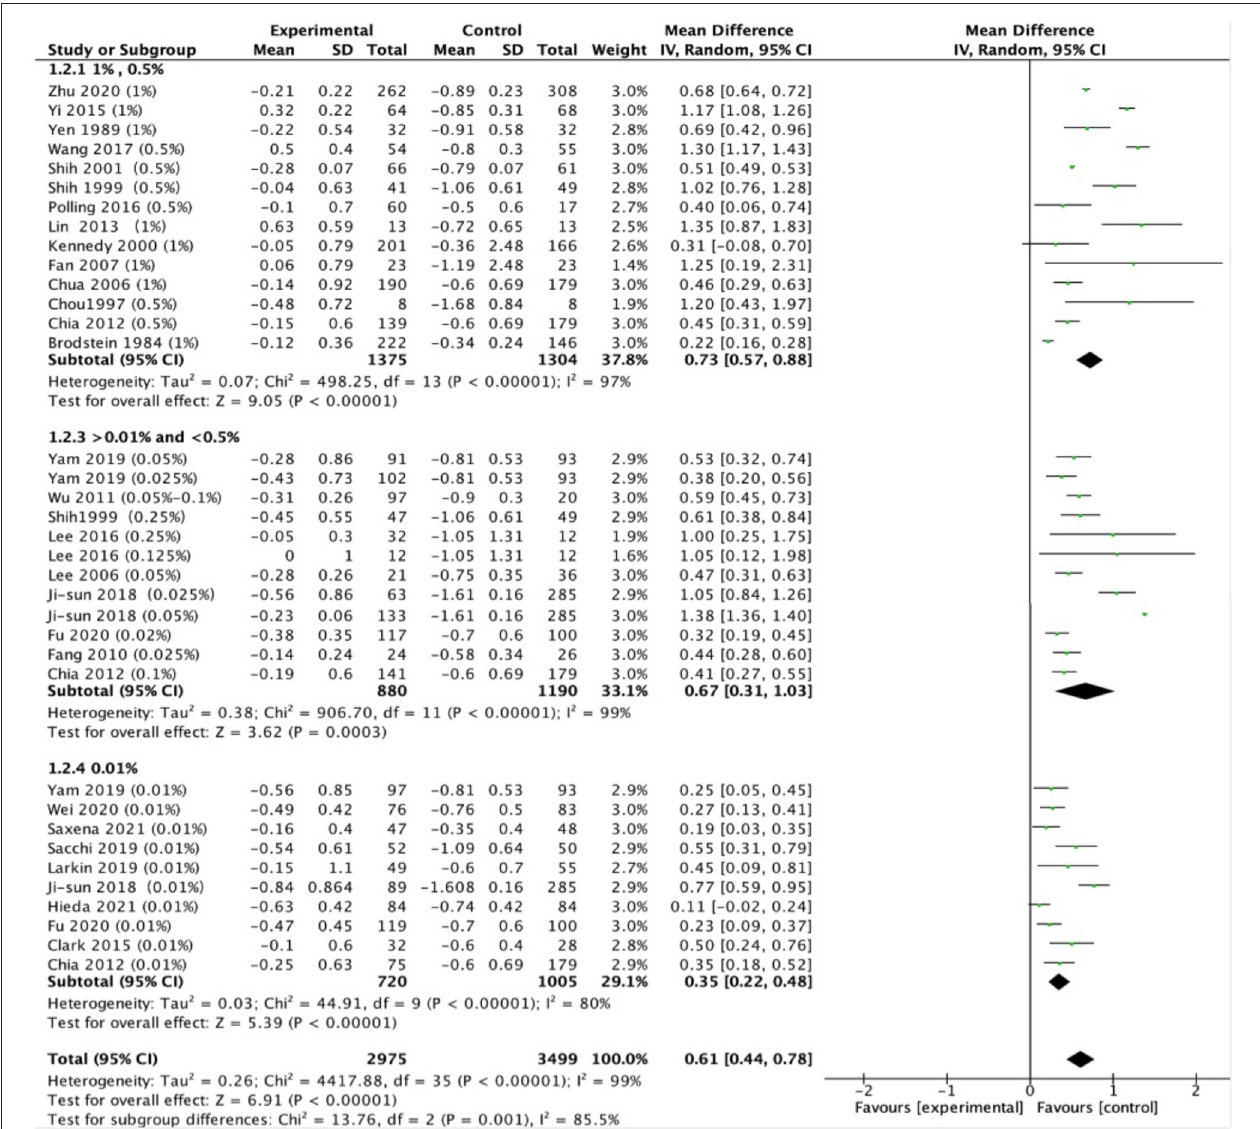
FIGURE 2 | Effects of different doses of atropine on slowing myopia progression (diopters/year).